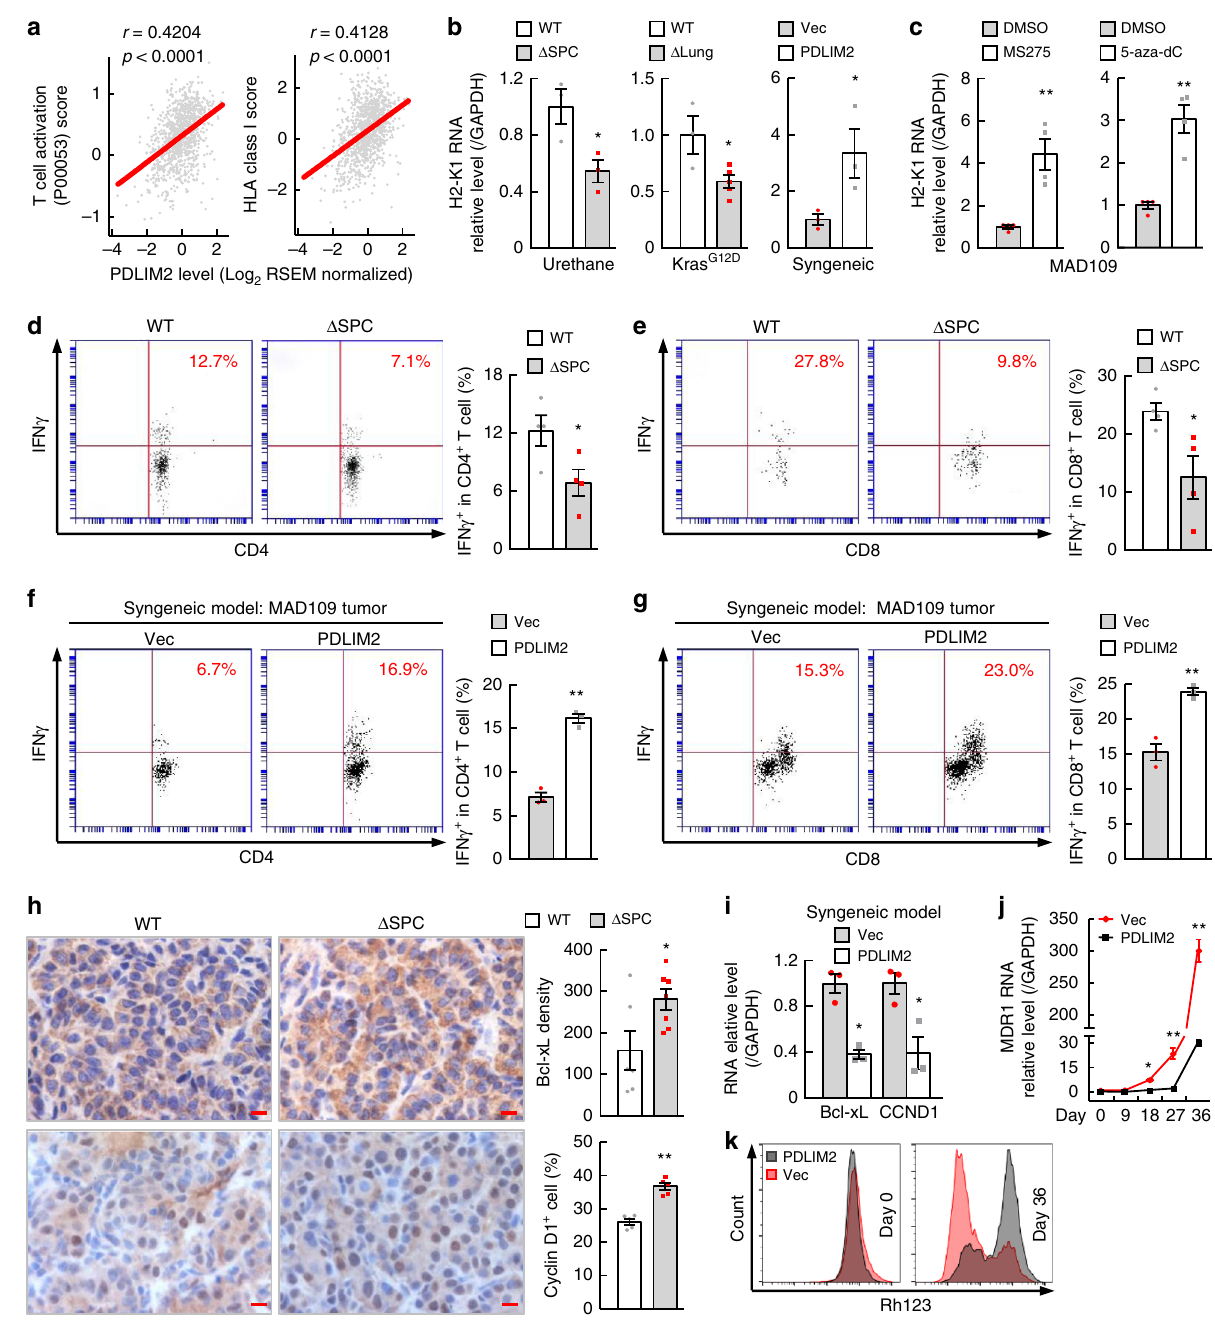
Fig. 5 PDLIM2 increases MHC-I expression, represses MDR1 and cancer-related genes in lung cancer cells, and stimulates T-cell activation. a TCGA data showing positive association between PDLIM2 expression and T-cell activation or HLA Class I expression in human lung cancer. Pearson ’ s correlation test was performed. b qPCR showing down-regulation of the MHC-I H2-K1 expression by PDLIM2 deletion and up-regulation by PDLIM2 reconstitution in lung tumors ( n ≥ 3). c qPCR showing up-regulation of H2-K1 expression in MAD109 lung cancer cells by epigenetic drugs ( n = 4). d – g FACS analysis showing decreased lung T-cell activation in Δ SPC mice in urethane model ( n = 4) and increased activation of tumor-in fi ltrating T cells by PDLIM2 reconstitution in MAD109 syngeneic model ( n = 3). h IHC showing increased Bcl-xL and Cyclin D1 in lung tumors by PDLIM2 deletion ( n ≥ 5). Scale bar, 10 μ m. i , j qPCR showing PDLIM2 repression of Bcl-xL and Cyclin D1 (CCND1) expression in MAD109 tumors ( i ) and MDR1 induction in A549 lung cancer cells ( j ) ( n = 3). k FACS of Rhodamine 123 (Rh123) showing PDLIM2 prevention of drug ef fl ux from A549 cells. Student ’ s t test (two tailed, unpaired) was performed, and data represent means ± SEM in ( b – j ). * P < 0.05; ** P <